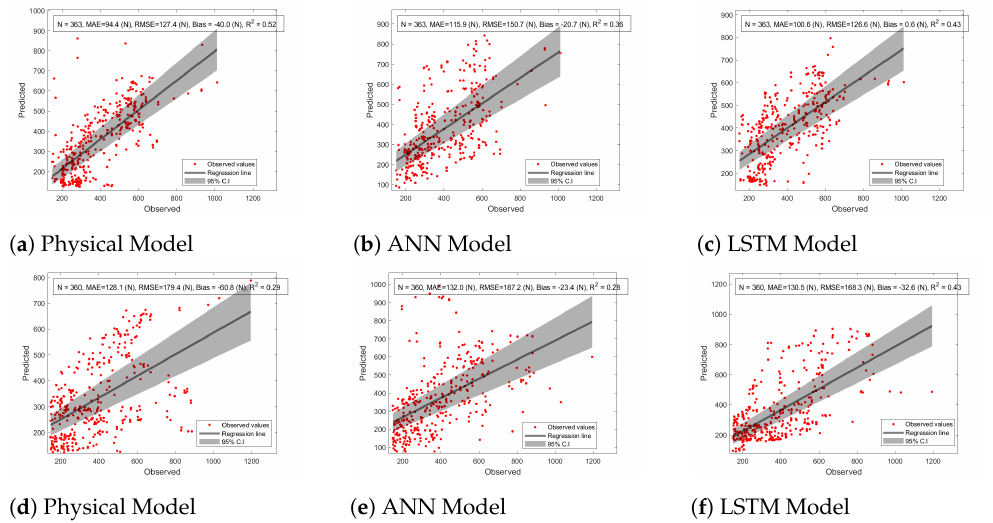
Figure 22. Scatter plots of the physical, ANN, and LSTM models: ( a – c ) the performance of the models under steady wind conditions, ( d – f ) the performance of the models under turbulent wind